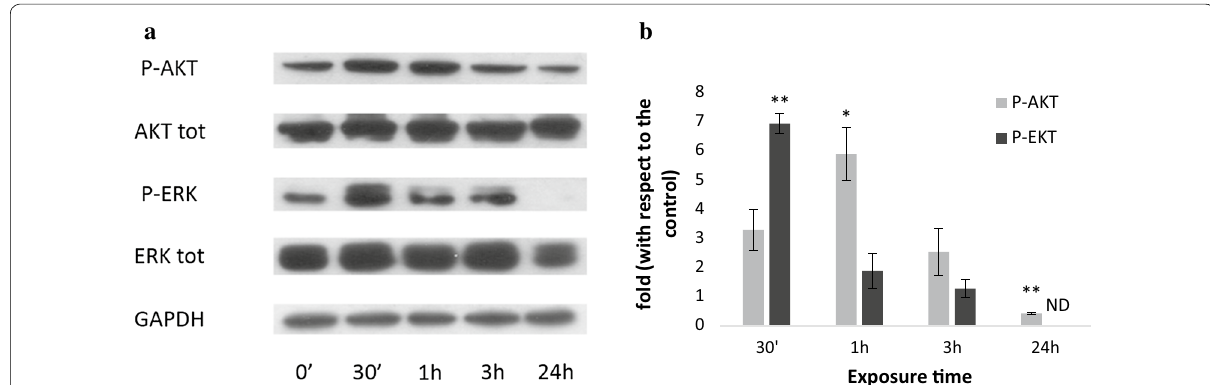
Fig. 7 Western blotting analysis of EGFR pathway activation after exposure to plantaricin P1053 in CCD 841 cell line. Representative western blotting analyses performed on crude extracts, using anti-P-AKT, anti-AKT, anti-P-ERK1/2, anti-ERK1/2 and anti-GAPDH antibodies. GAPDH was used as a control. The experiments were performed in triplicate ( a ). Densitometric analysis performed with Scion Image Software. Values are expressed by comparing the data obtained after the treatment with plantaricin P1053 with those obtained from 0’ of exposition to the compound ( b ). Values are presented as mean SD. ND, no protein phosphorylation was detected ±